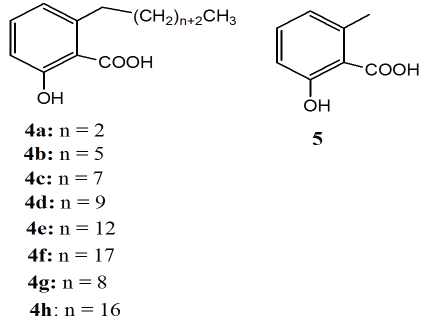
Figure 2. Synthetic anacardic acids, 4 and 5 .